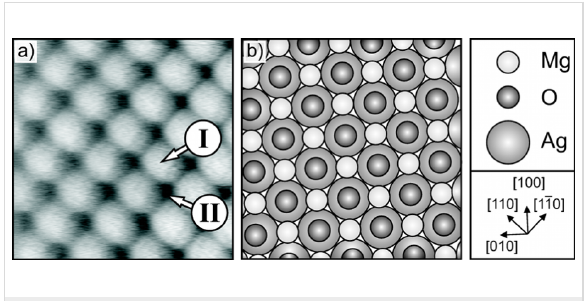
Figure 5: Magnesium oxide surface. a) Atomically resolved image recorded by NC-AFM. The position I and II indicate the two different surface atoms, oxygen and magnesium. The size is 1.5 nm x 1.5 nm and the corrugation approximately 30 pm. Δ f = − 8.5 Hz, A osc = 0.35 nm. b) Schematic growth model of the MgO on Ag(001). The oxygen atoms occupy top sites, while the magnesium atoms occupy hollow sites